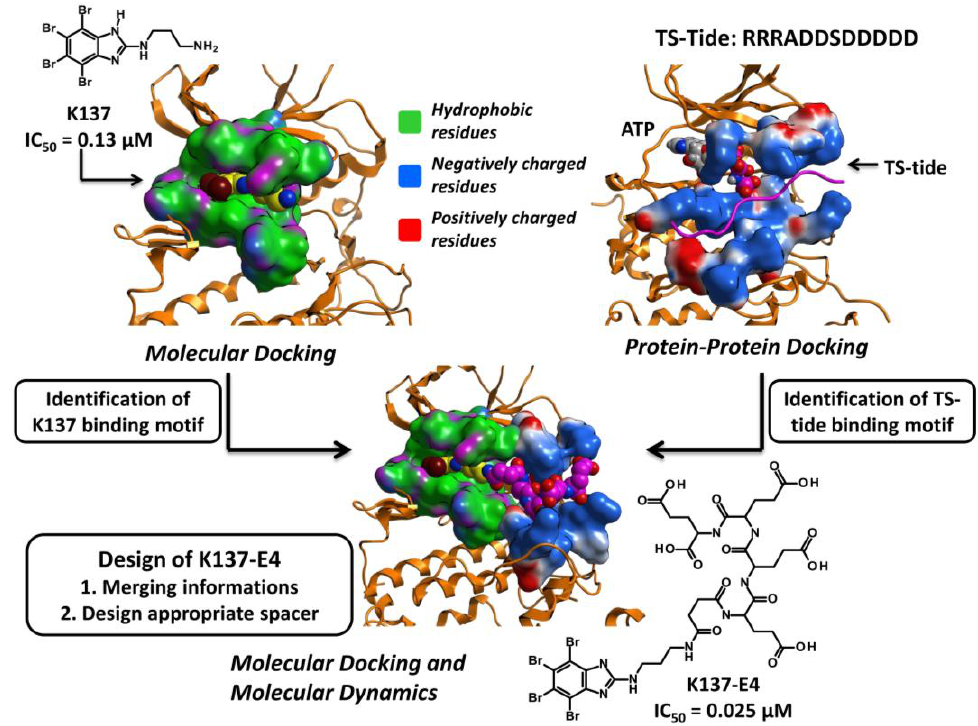
Figure 8. Schematic representation of the rational strategy leading to the design of bisubstrate inhibitors.